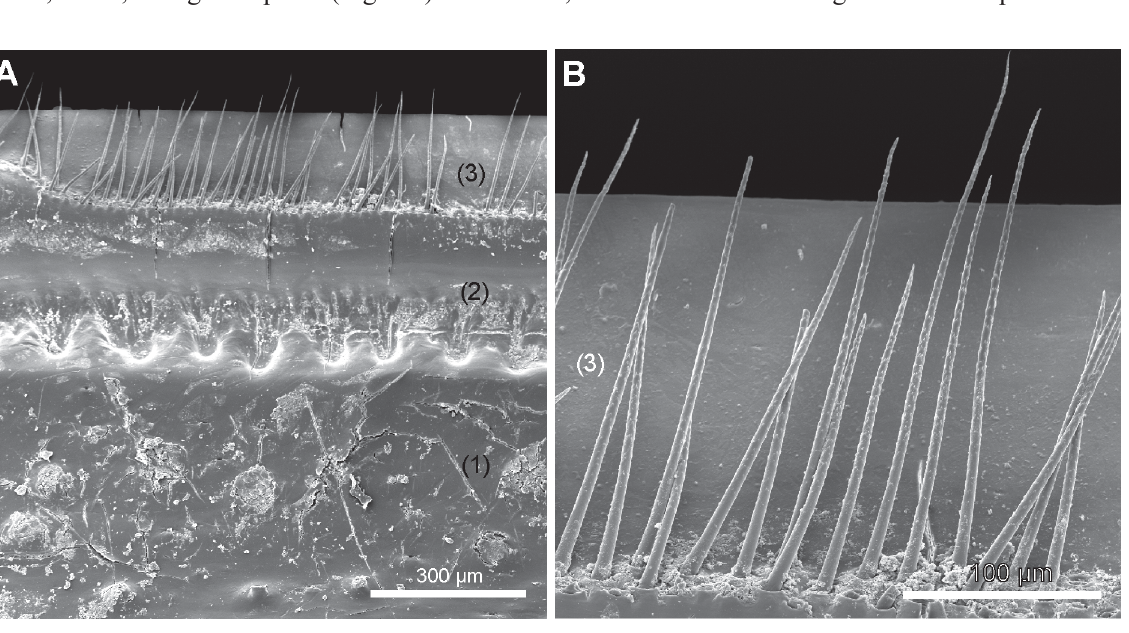
Fig. 8. Sphaeromimus midongy sp. nov., SEM of endotergum, ♂, holotype ( FMNH-INS 3119888). A . Overview, endotergum. B . Margin of endotergum, detail. Abbreviations: (1) = inner part; (2) = middle part; (3) = outer